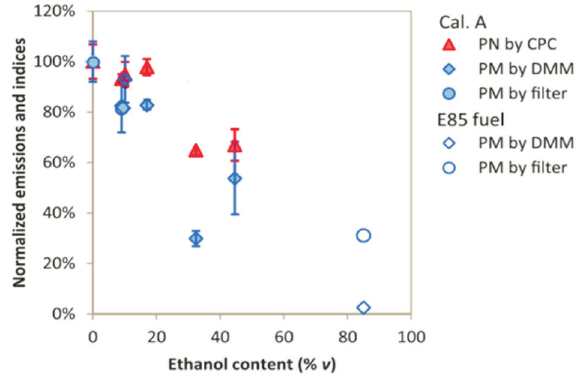
Fig. 7. Vehicle PN emissions and PM emissions by DMM and by filtra - tion, on FTP cycle for vehicle calibration A